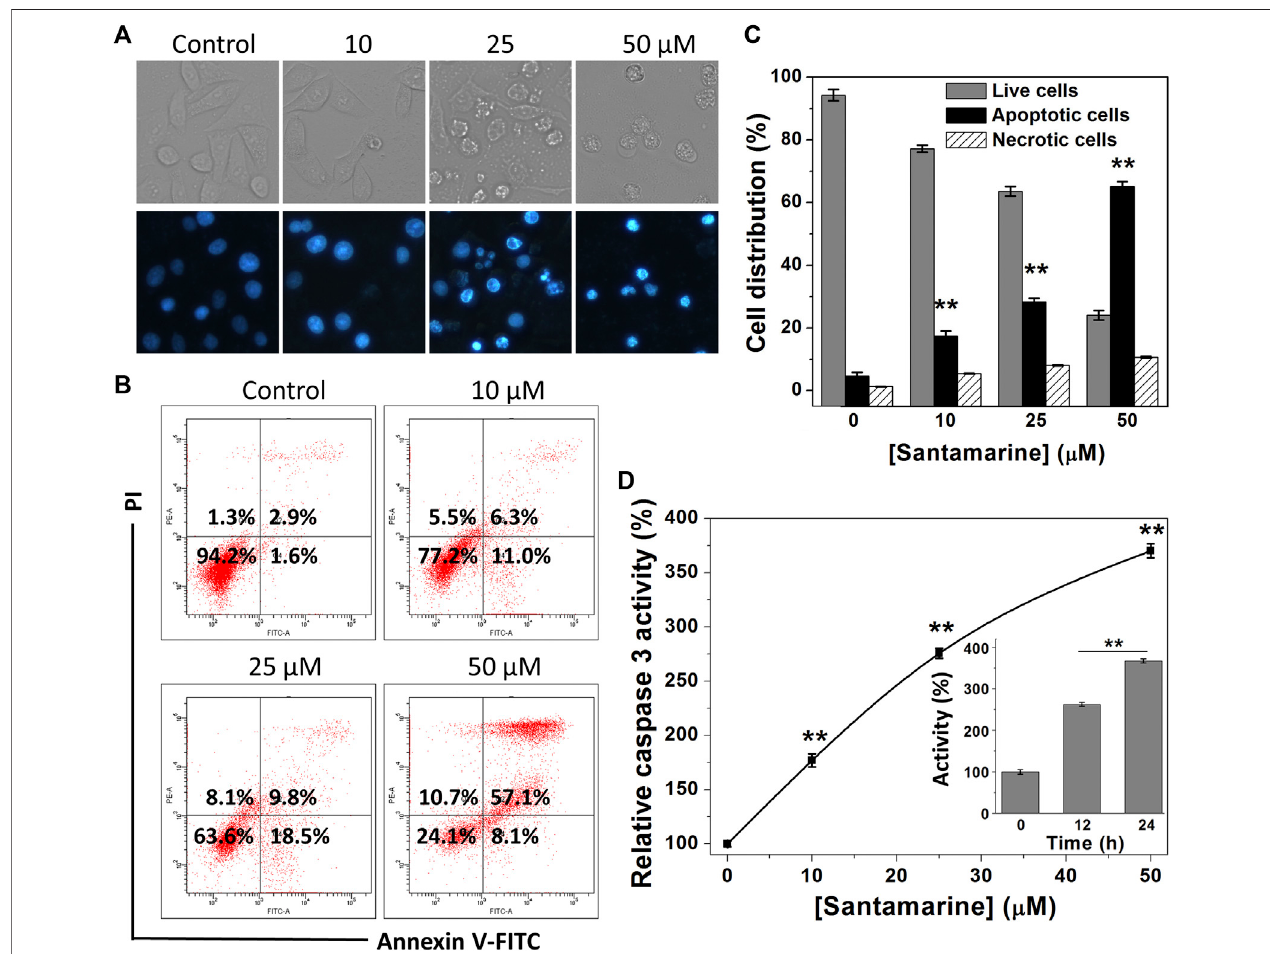
FIGURE6| Santamarineeffectsoncellapoptosis. (A) HeLacellsweretreatedvehicle(control)anddifferentconcentrationsofsantamarinefor24 h,andtheimages of the cells stained with Hoechst 33342 solution were captured in representative phase contrast (top) and fl uorescence (bottom). The images represent three independent experiments performed in triplicate. Scale bar (cid:2) 20 μ m. (B) HeLa cells were treated with the speci fi ed dose of santamarine for 24 h, and then analyzed for the Annexin V-FITC and PI staining by fl ow cytometry. (C) The average value and SD of live cells, apoptotic cells, and necrotic cells in three independent experiments stained with Annexin V-FITC and PI after 24 h of HeLa cells treated with santamarine. (D) Santamarine activated intracellular caspase 3 activity in a concentration and time-dependent manner. HeLa cells were incubated with santamarine at the speci fi ed concentrations for 24 h, or 50 μ M santamarine was used to treatHeLacellsforaspeci fi edtime(inset),andthecaspase3activityinthecellextractwasdetectedbycolorimetricanalysis.Thedatawasexpressedasapercentageof the control sample. ** p < 0.01 vs. the control group in (C) and (D)